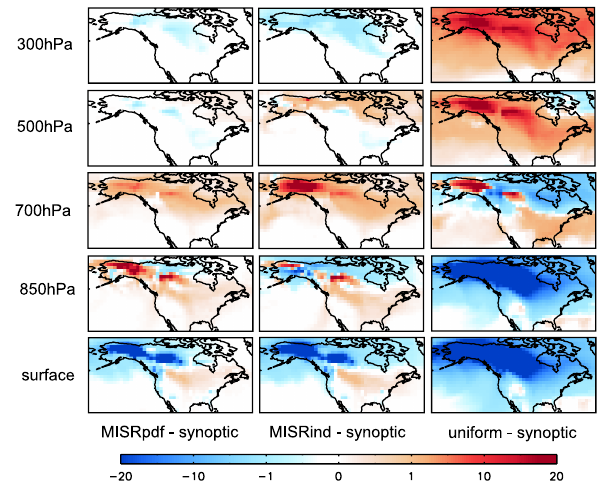
Fig. 6. Differences of model simulated 3-month (June– August 2004) average CO mixing ratios (ppbv) at five pressure lay- ers (surface, 850hPa, 700hPa, 500hPa, 300hPa) due to the use of each injection height distribution of biomass burning emissions.